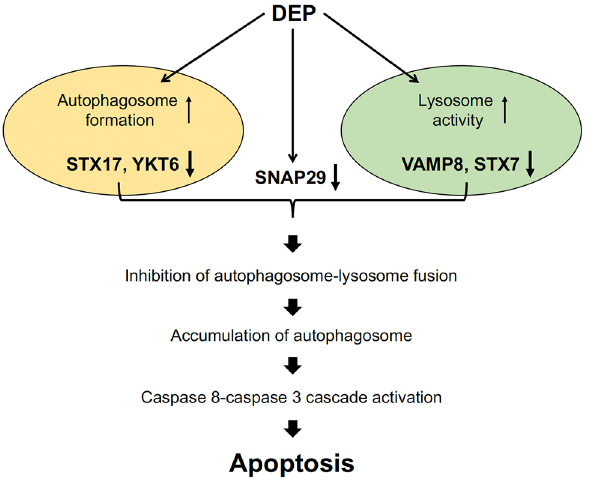
Figure 7. Schematic model for DEP-induced ECs apoptosis. In response to DEP exposure, HUVECs initiate the autophagic pathway, form the autophagosome, and increase lysosomal activity. However, DEP suppress expression of several SNARE proteins and block autophagosome maturation, leading to caspase-8 activation and subsequent caspase-3-dependent